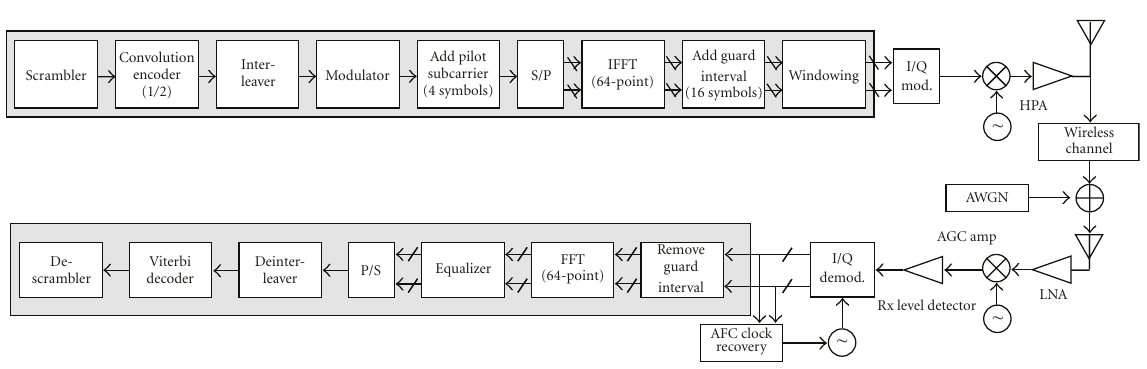
Figure 1: System model of IEEE802.11a and IEEE802.11p physical